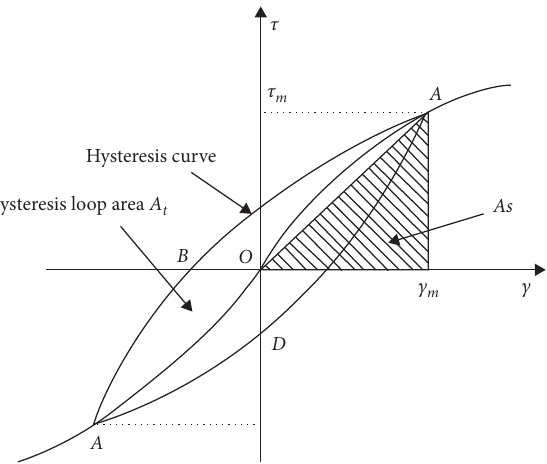
Figure 3: Typical stress-strain hysteresis curve.